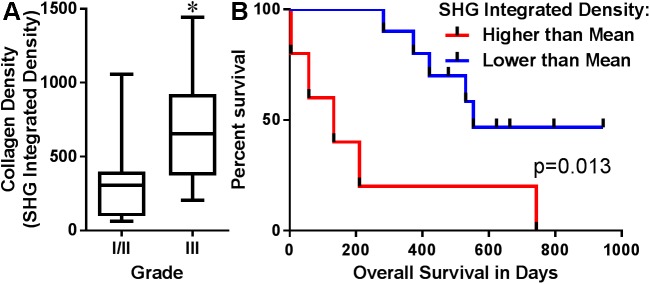
Collagen density predicts poor outcome in canine mammary tumors.Integrated density of collagen signal from SHG images was quantified using Fiji (Image J) software. Graph represents averages from 5 images per tumor from 11 grade I/II and 9 grade III mammary tumors. *p<0.05 via an unpaired Mann-Whitney test (A). Kaplan-Meier survival curve for 18 dogs with collagen integrated density higher or lower than the mean integrated density value (B). The log-rank test was used to evaluate whether the collagen density significantly impacted survival (p = 0.013, HR 4.099, 95%CI 0.860–19.520).